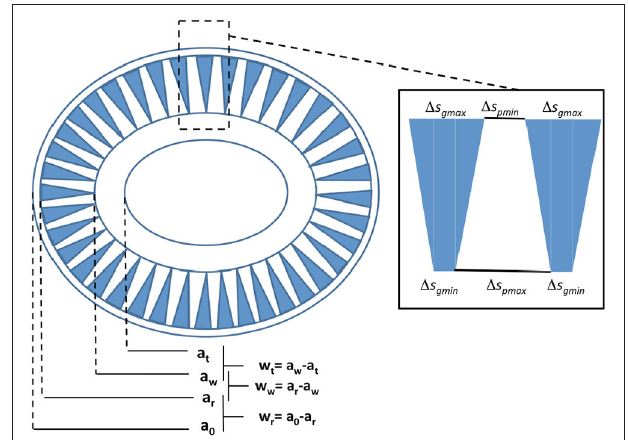
FIGURE 2 | Schematic representation of the morphology of an E. huxleyi coccolith as measured by Young et al. (2014). The inset describes details of the wedge structure of the